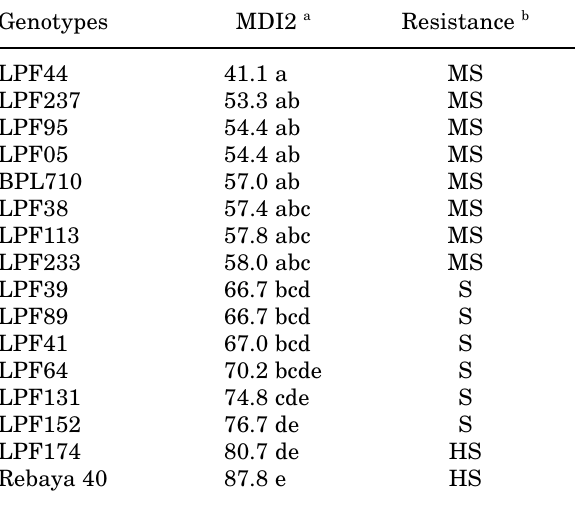
Table 5. Fourteen genotypes of Vicia faba tested under greenhouse conditions according to their mass disease index